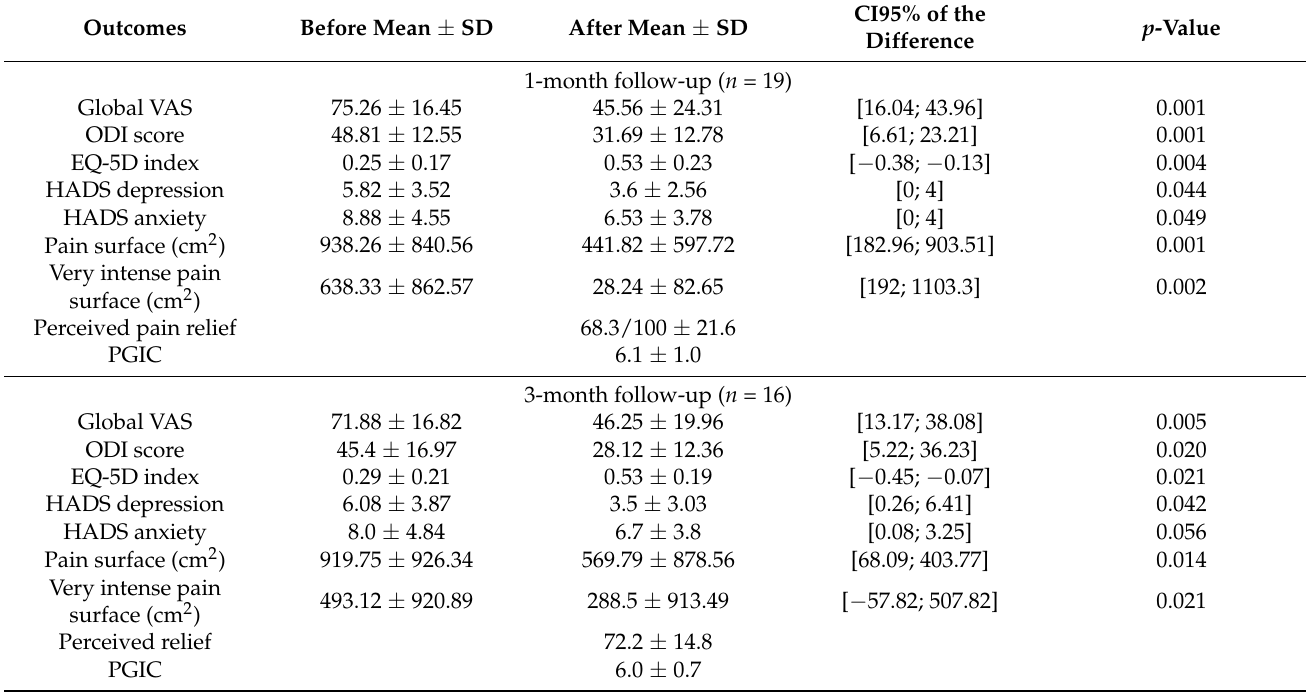
Table 2. Outcomes comparisons between baseline and 1-month, 3-month, 6-month and 12-month follow-ups ( n =